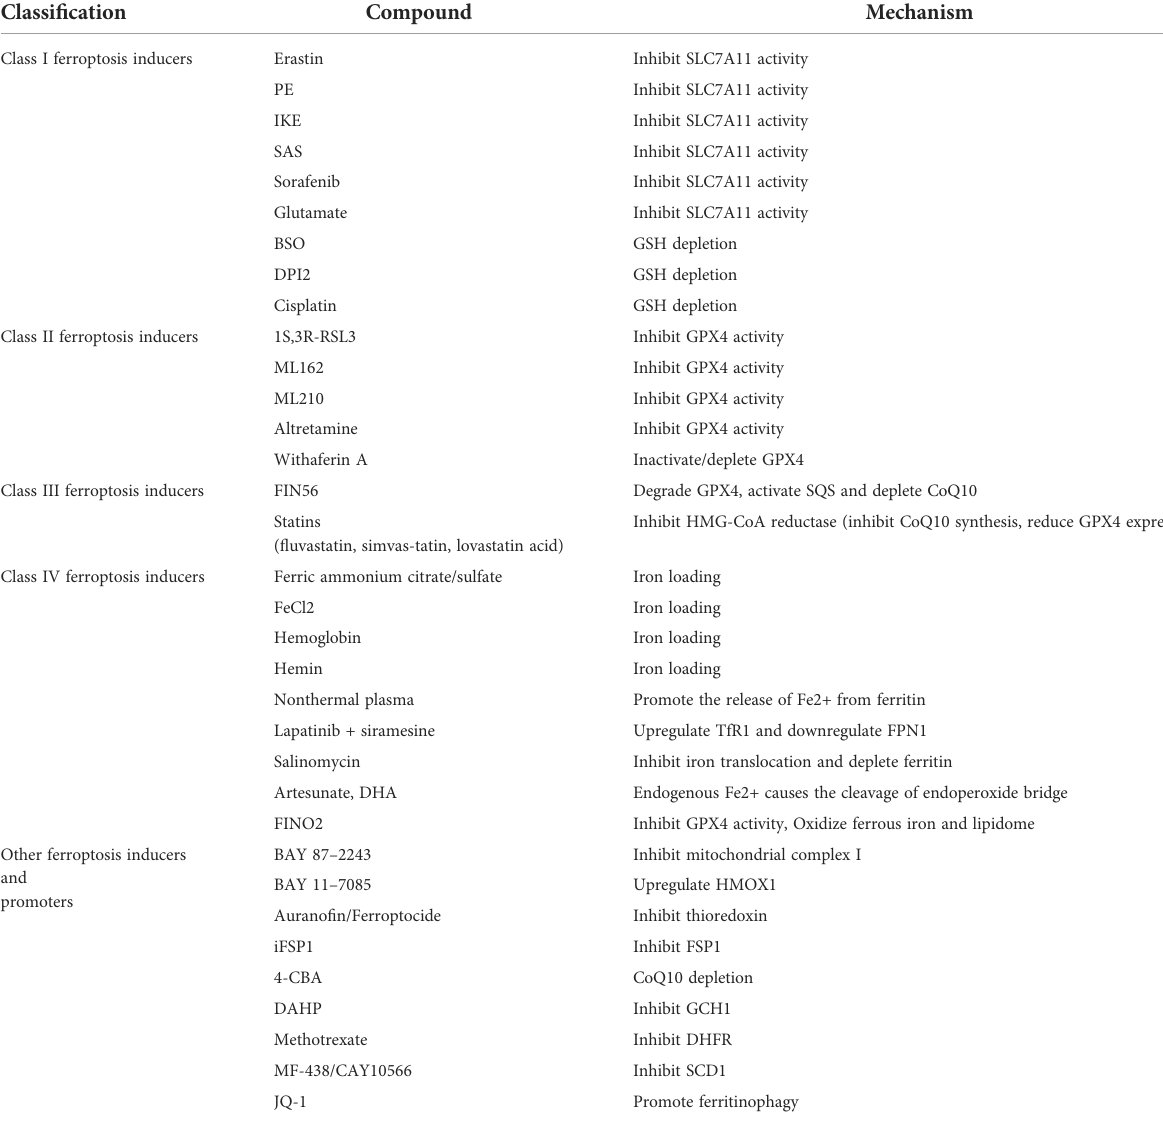
TABLE 1 This table lists compounds currently known to induce or promote ferroptosis as sensitizers in the treatment of